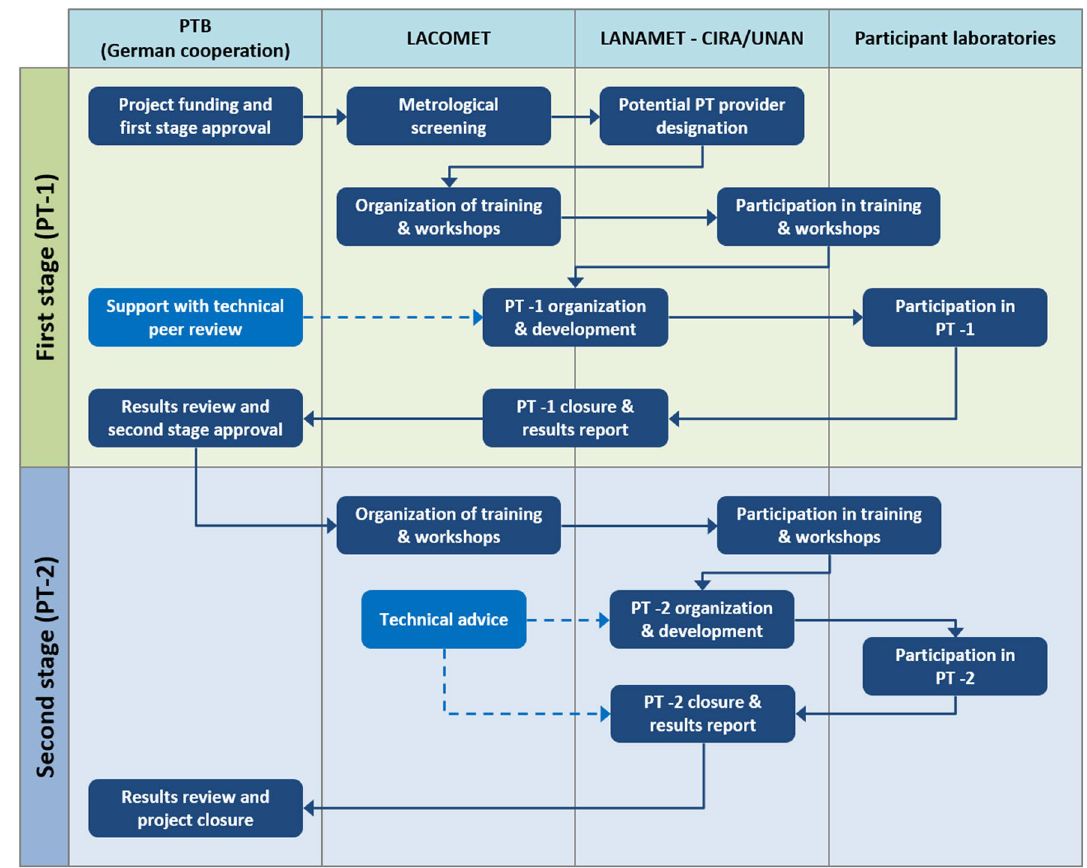
Figure 1. Development of the two-stage multilateral cooperation